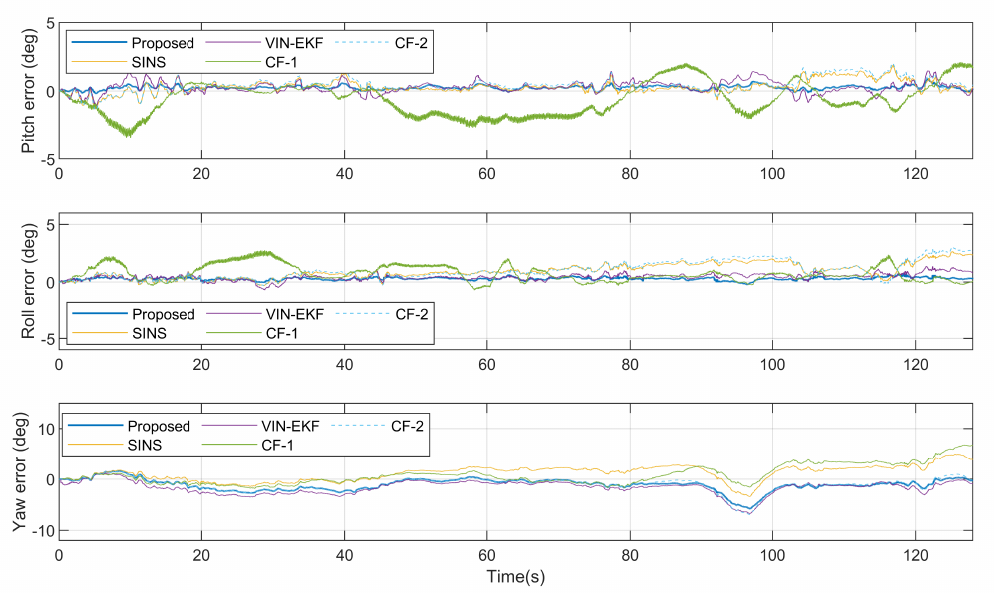
Figure 7. Attitude estimation error in the dynamic